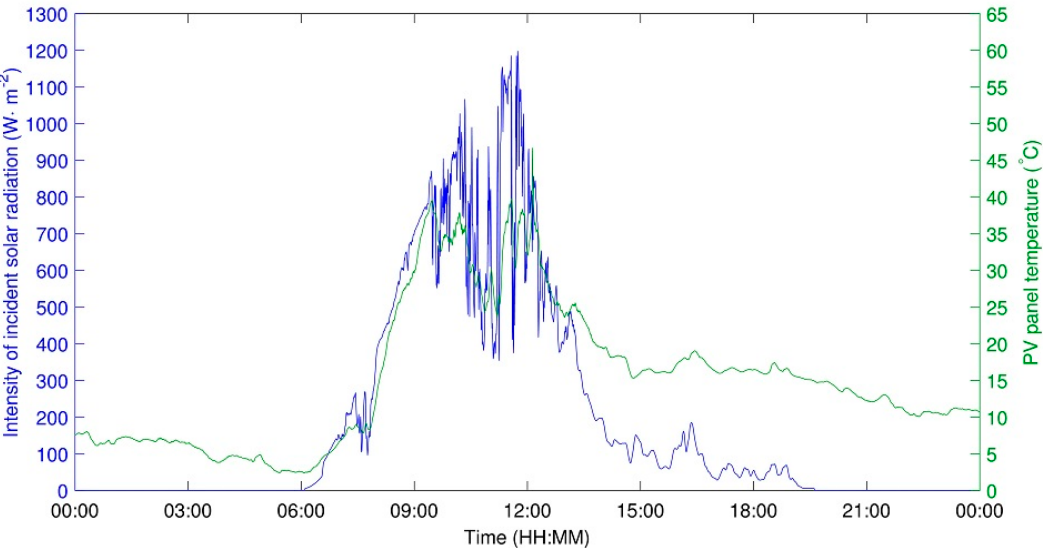
Figure 12. Intensity vs. time profile of solar radiation incident on PV field and PV panel temperature.